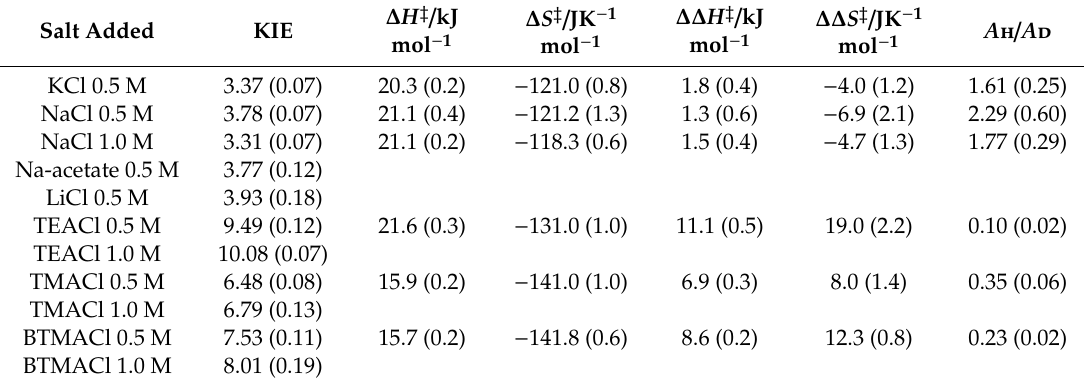
Table 3. Kinetic isotope e ff ects, activation parameters ∆ H ‡ and ∆ S ‡ , isotopic di ff erences ∆∆ H ‡ (D,H) and ∆∆ S ‡ (D,H) and ratios A h / A d in the reaction of ascorbate with hexacyanoferrate(III) ions in more concentrated aqueous solutions of salts. Adapted from